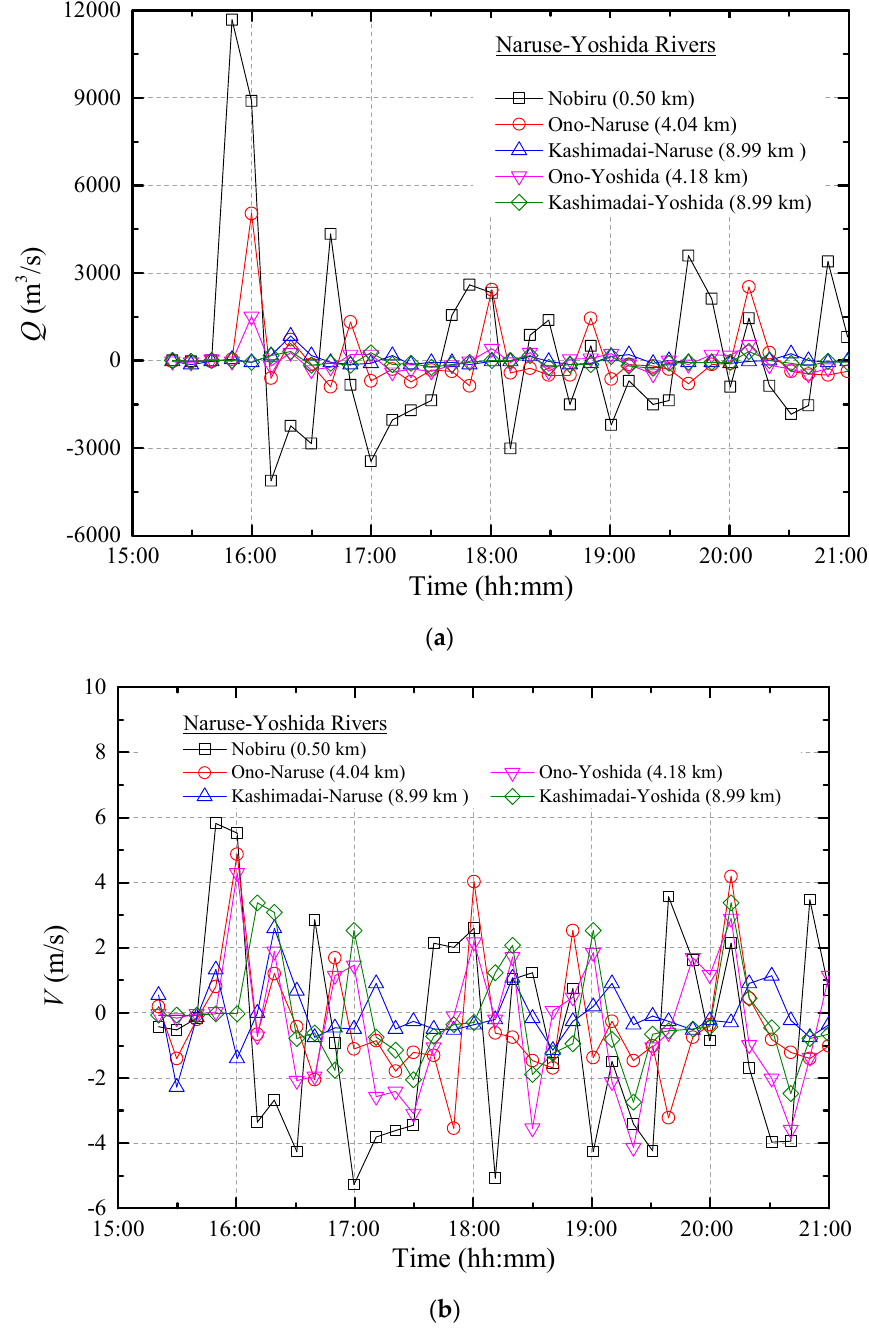
Figure 11. Estimated discharge and flow velocity of Naruse and Yoshida Rivers (11 March 2011). ( a ) River discharge variation, and ( b ) flow velocity.